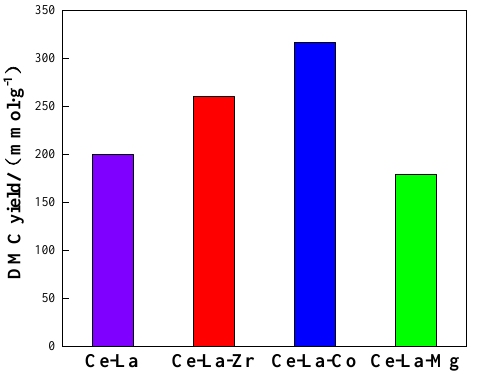
Figure 6. Catalytic performance of the catalyst. Reaction conditions: Ce-La-M 0.1 g, methanol: 2-cyanopyridine = 2:1, Temperature: 413 K, Pressure: 8 MPa.